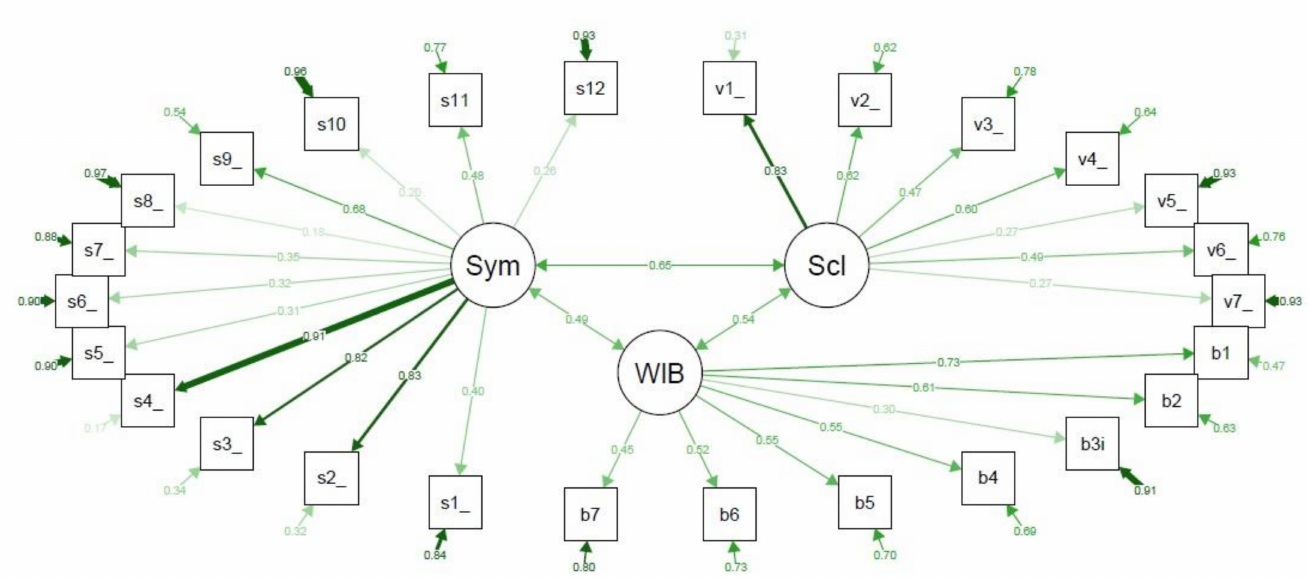
Figure 1. Confirmatory factor analysis of the Cardiff Wound Impact Schedule (CWIS) domains. Sym, Physical symptoms and everyday living; Scl, Social life; WIB, Well-being. v1–v7 are the items of the Social life domain. b1–b7 are the items of the Well-being domain. s1–s12 are the items of the Physical symptoms and everyday living domain. Each arrow between the questionnaire items and the subscale that they are measuring shows the standardized pattern coefficients for this relationship, where values closer to 1.0 (wider and darker) are indicative of better fit, and the circled arrow represented in each questionnaire item shows the residuals. The arrows connecting the subscales show the pairwise correlation between them. Comparative fit index (CFI) = 0.69; root mean square error of approximation (RMSEA) = 0.09; standardized root mean square residual (SRMR) =